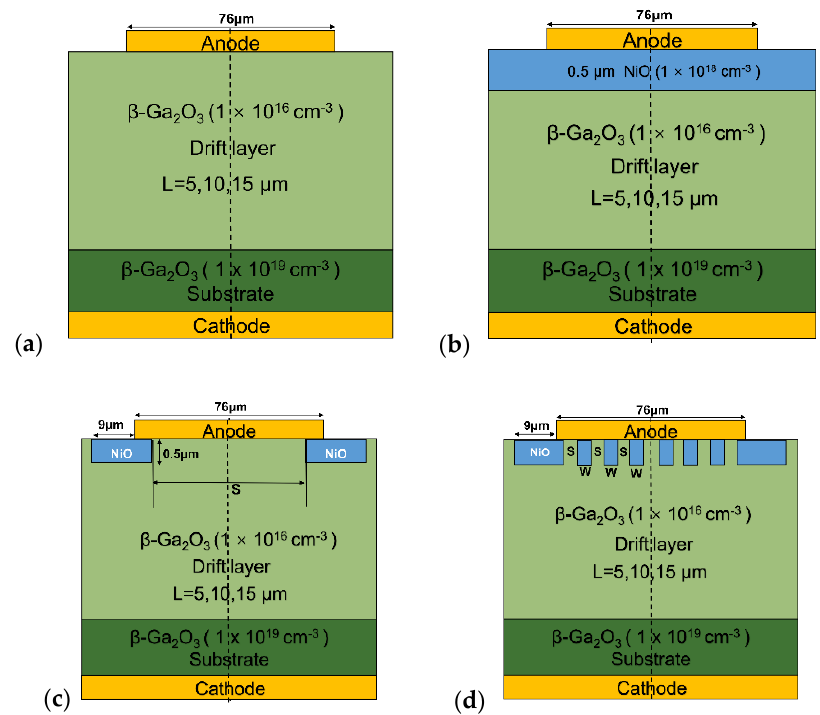
Figure 1. Schematic of the vertical NiO/Ga 2 O 3 diode; ( a ) SBD without p-NiO, ( b ) HJ-PN diode, ( c ) SBD with GRs, ( d ) HJBS diode. Table 1. Material parameters used for